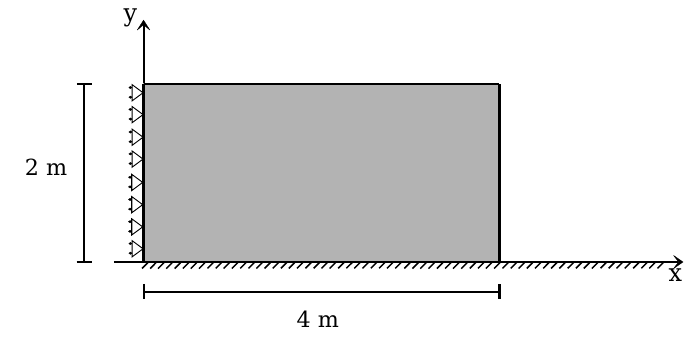
Figure 9. Granular column collapse.